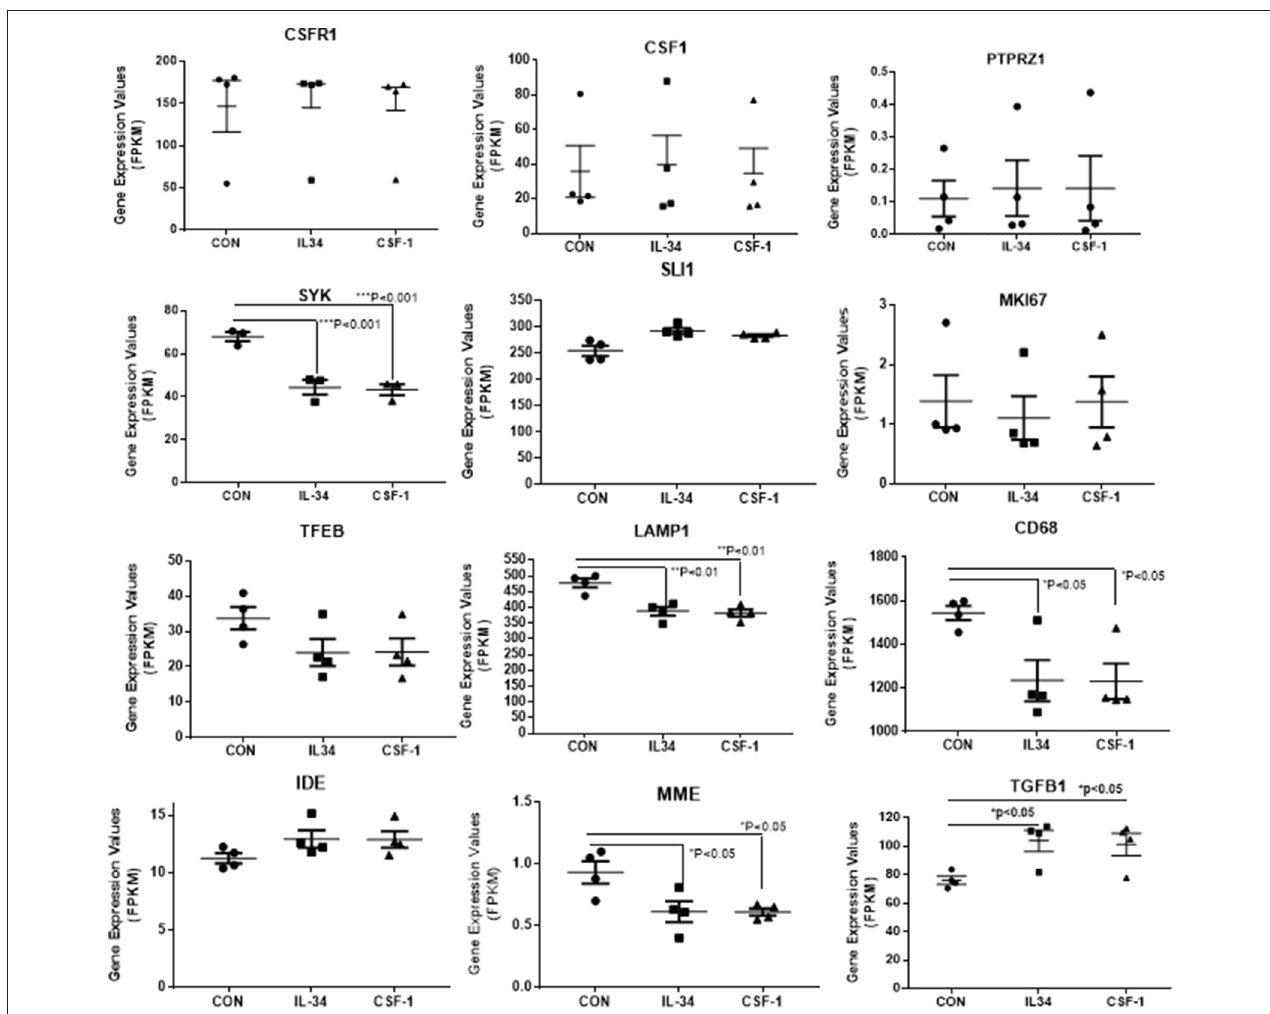
FIGURE 5 | Scatter plots showing levels of expression of transcripts (FPKM) of key markers of activation and function expressed in control, IL-34, and CSF-1-stimulated human brain microglia ( n = 4) for each treatment. Results were obtained by RNA sequencing. Due to the small number of cases, there was not statistically significant difference between groups in all cases, but many of the selected genes show trends for upregulation or downregulation of expression consistent with an altered phenotype of microglia. Data were analyzed by one-way ANOVA with Fisher LSD post-hoc test for between group significance. Bars on figures indicate mean ± standard error of mean (SEM) for each analyses. Significant changes were shown for expression of SYK, LAMP-1, CD68, MME, and